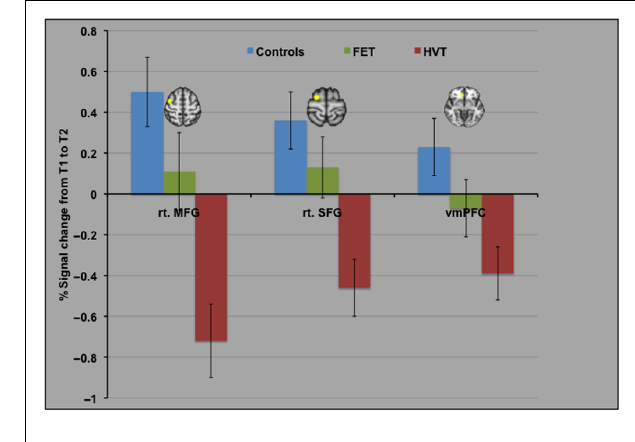
FIGURE 5 | Cortical areas recruited by the FET participants relative to the HVT participants at post-training, when compared to pre-training. All axial slices are presented in radiological orientation. Table 4 | Statistical peaks of cortical regions recruited during the Active > Passive condition atTime 2 > Time 1 contrasting the FET group with the HVT group (FET >